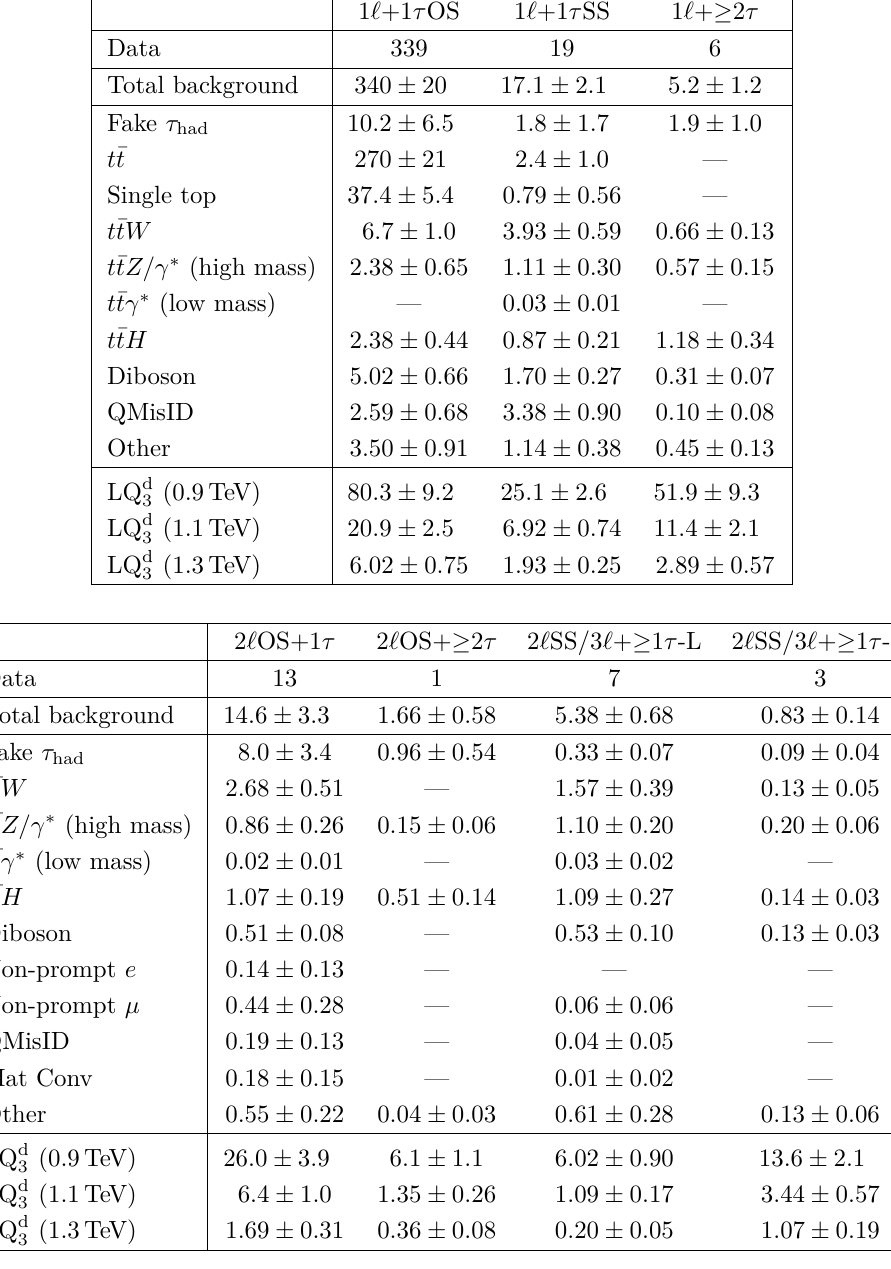
Table 10. Summary of observed and predicted yields in the seven signal region categories. The background prediction is shown after the combined likelihood fit to data under the background-only hypothesis across all control region and signal region categories. The expected signal yields that are obtained by using their theoretical cross sections are also shown with their pre-fit uncertainties, assuming B = 1 . Dashes refer to components that are negligible or not